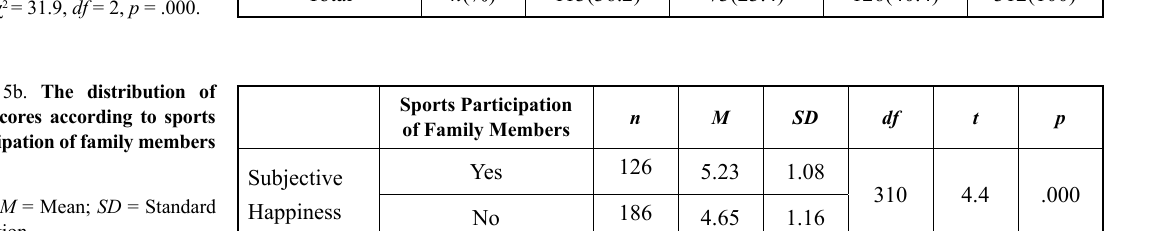
Note. χ 2 = 31.9, df = 2, p = .000.